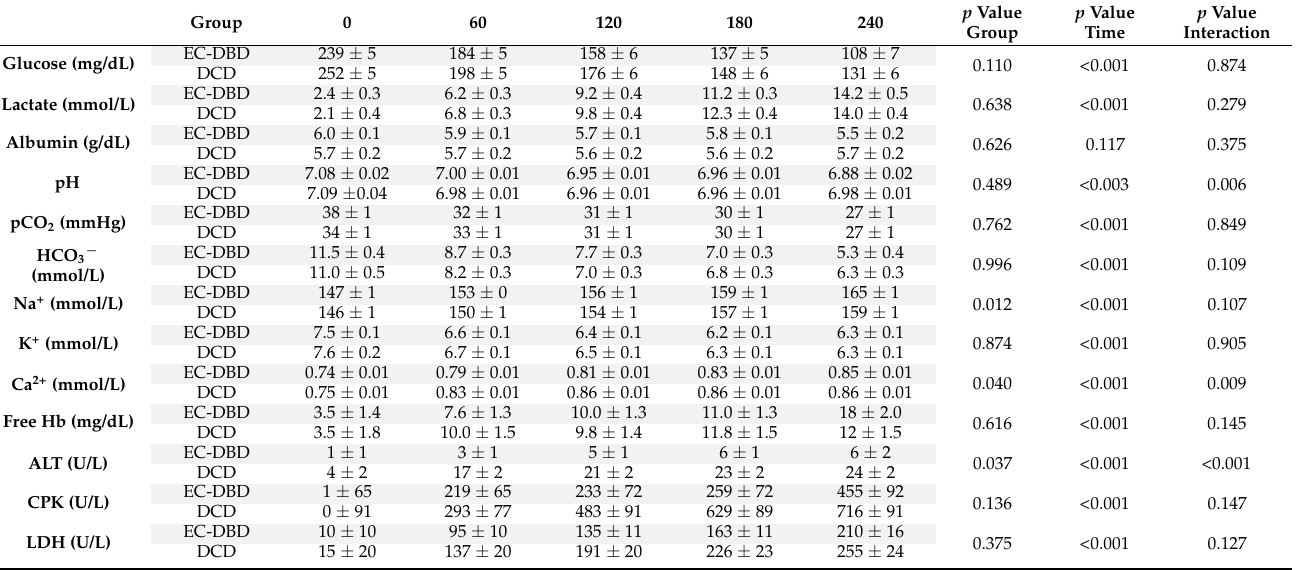
Table 3. EVLP Perfusate